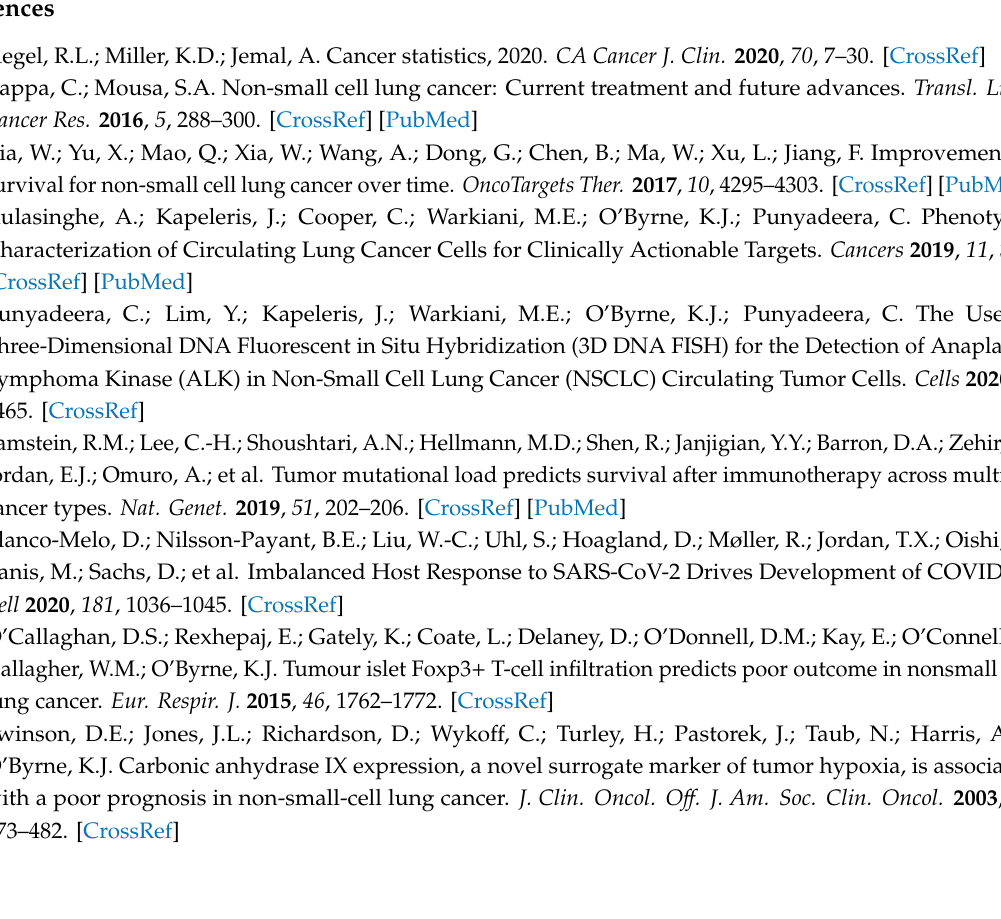
Figure S1: Range of probe counts from ROI-1 (Top) to ROI-96 (Bottom), Figure S2: Probe counts per compartment from most abundant (Top) to least abundant (Bottom), Figure S3: Pearson correlation matrix of proteins within TME ROIs and Figure S4: Pearson correlation matrix of proteins within tumour